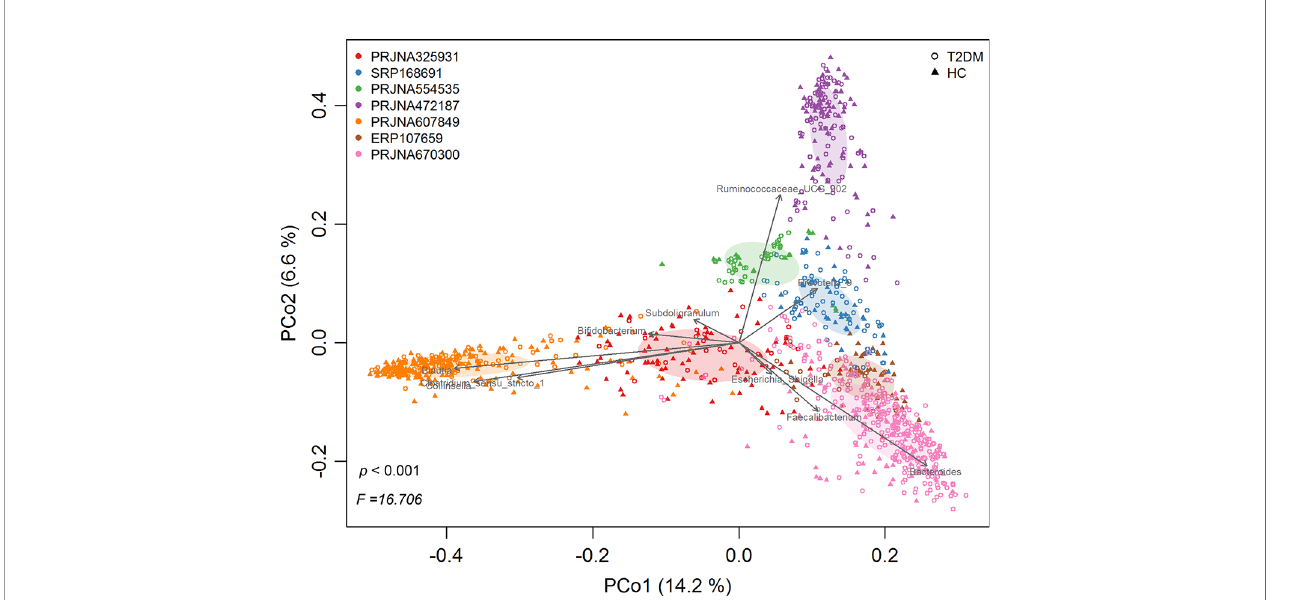
FIGURE 1 | The principal coordinates analysis (PCoA) of all samples at OTU level, depicting the great microbial variations from different studies with population variation, DNA extraction methods, 16S rRNA gene regions investigated, sequencing platforms, etc. The points represent samples, shapes represent the different group, and the colors represent the different study. Top 10 genera with signi fi cant ( P < 0.001, p < 0.05 ) correlations were fi tted to the